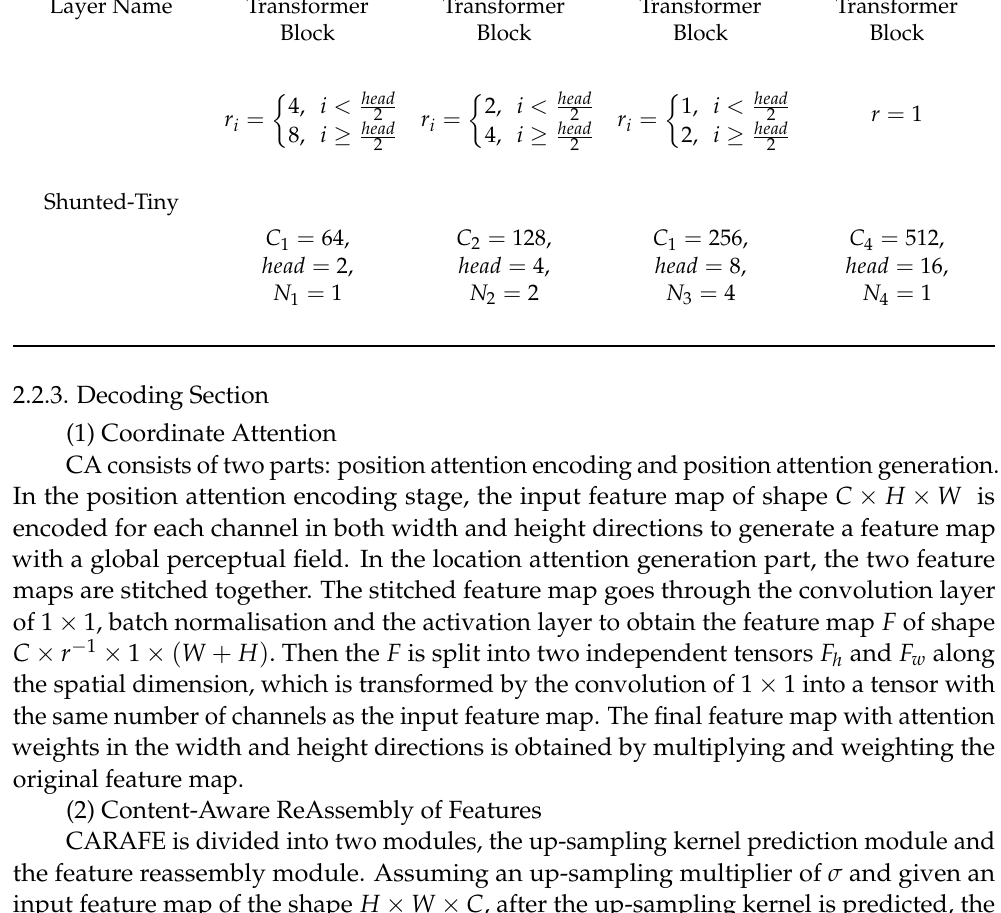
Table 2. Selected parameters in different phases of the shunted-tiny model. Head indicates the number of heads in a shunted transformer block, N i indicates the number of shunted transformer blocks in a phase, C i indicates the output dimension. Stage 1 Stage 2 Stage 3 Stage 4 Shunted Shunted Shunted Shunted Transformer Transformer Transformer Layer Name Transformer Block Block Block Block